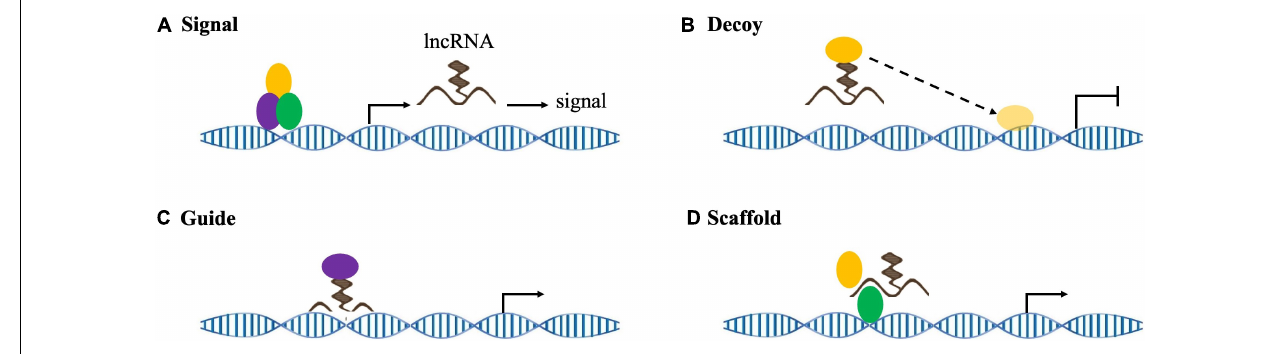
FIGURE 3 | lncRNA mechanisms of action. (A) As signaling molecules, lncRNAs convey specific cell development and spatiotemporal information to regulate corresponding gene expression. (B) As decoy molecules, lncRNAs sequester target molecules, which inhibits downstream functions. (C) As guide molecules, lncRNAs recruit chromatin modification complexes to target genes in either cis or trans . (D) As scaffold molecules, lncRNAs form functional complexes to participate in histone modification and/or stabilize nuclear